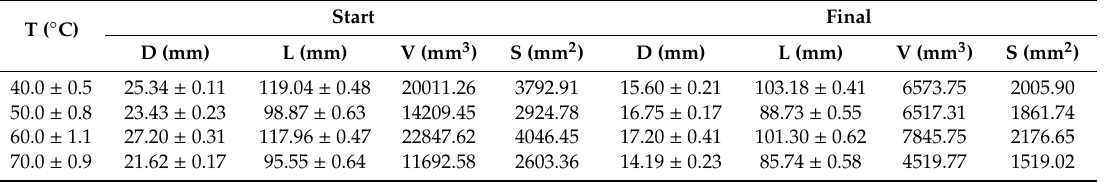
Table 3. Dimensional data of the longitudinal sliced banana during drying.